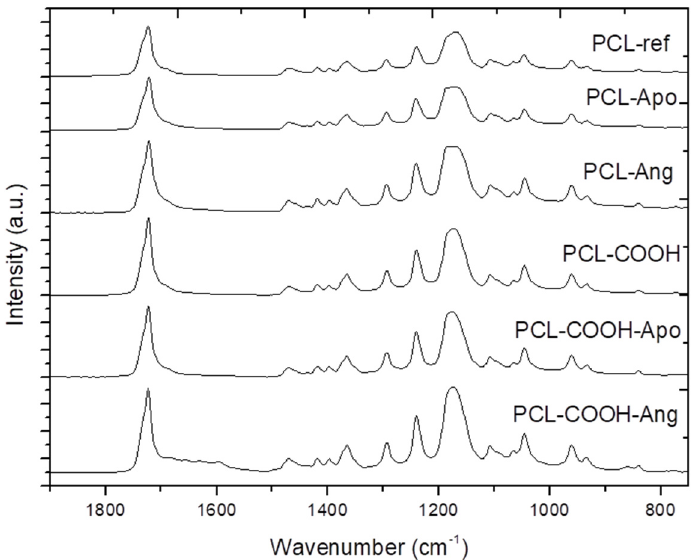
Figure 3. The FT-IR spectra of the PCL nanofibers.